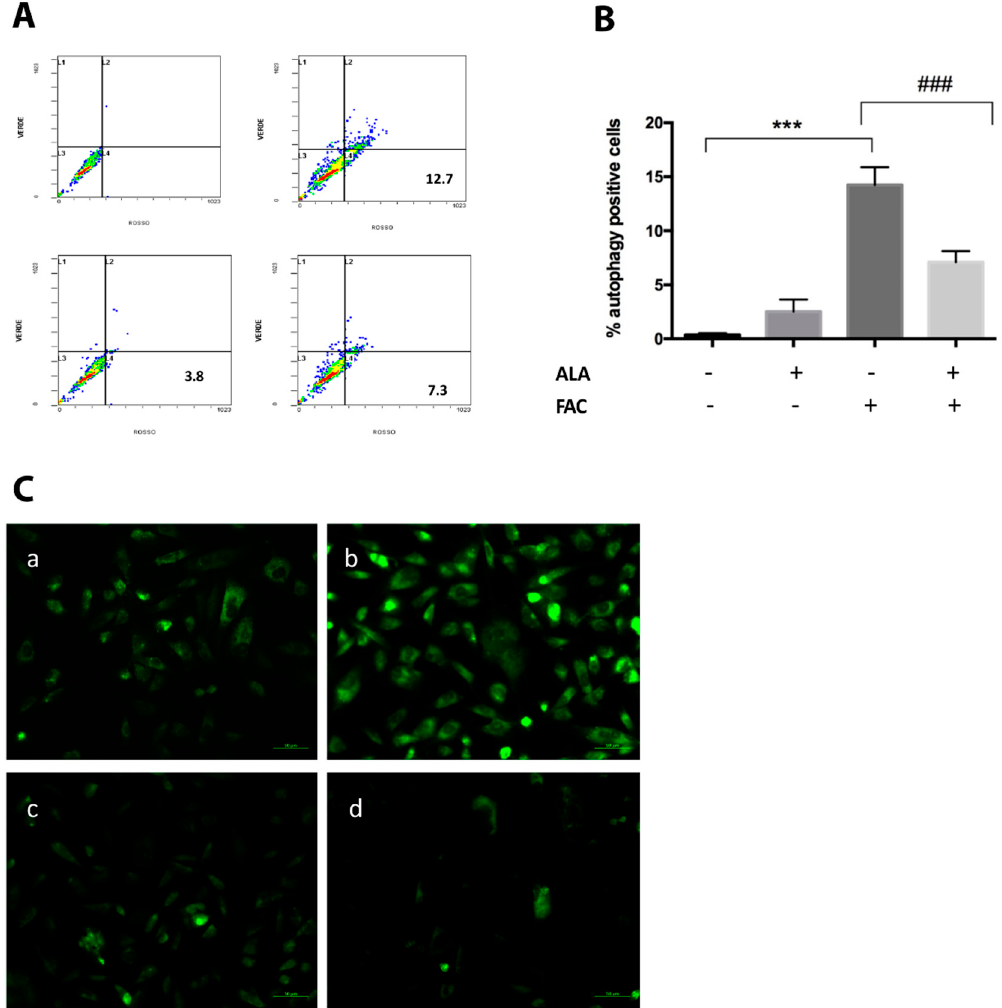
Figure 4. FACS analysis of autophagy induction in HS-5 cell cultures following FAC treatment (120 µg/mL) alone and in combination with ALA (20 µg/mL) ( A – B ). Results are presented as the percentage of positive cells to Acridine-orange staining (*** p < 0.0001 vs. untreated control; ### p < 0.0001 vs. FAC alone treatment). The immunofluorescence image showed LC3-II localization in untreated HS-5 cells ( C . a ) following FAC treatment ( C . b ) and ALA alone ( C . c ) or in combination with FAC ( C . d ). All values are presented as mean ± SE of four experiments in duplicate.